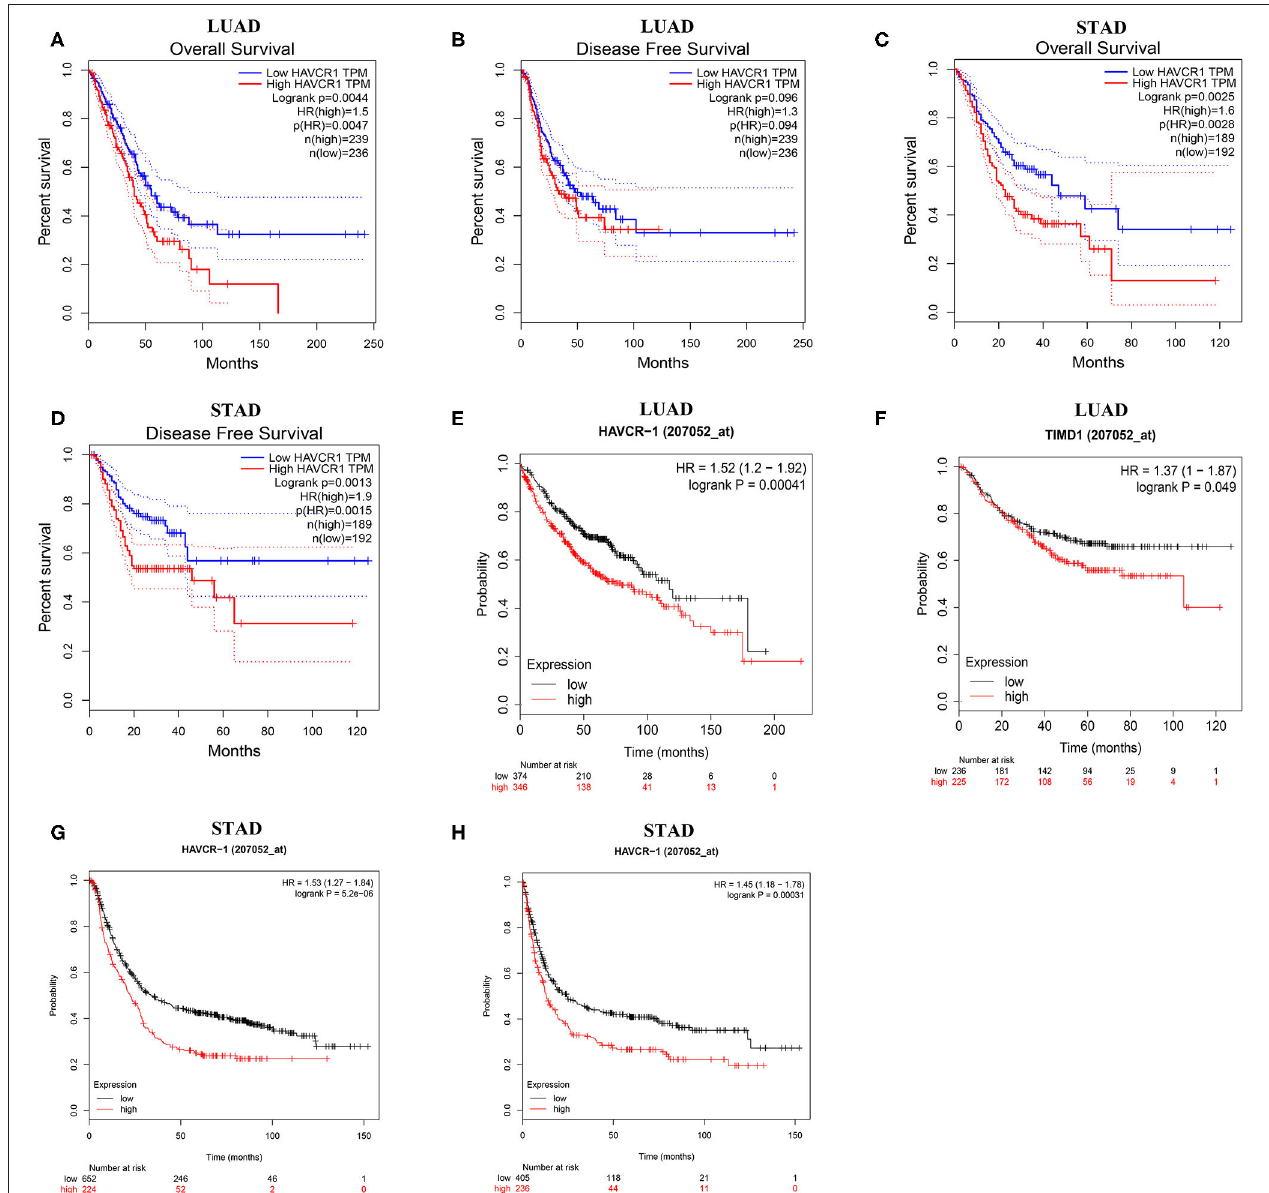
FIGURE 3 | Kaplan-Meier survival curves comparing the high and low expression of TIM-1 in different types of cancer in the TCGA dataset and GEO dataset. (A–D) Survival curves of OS and DFS in gastric cancer and lung adenocarcinoma in TCGA cohorts. (E,F) Survival curves of OS and PFS in six lung adenocarcinoma cohorts (GSE29013, GSE31210, GSE31908, GSE43580, GSE50081, GSE8894). (G,H) Survival curves of OS and PFS in six gastric cancer cohorts (GSE62254, GSE14210, GSE15459, GSE22377, GSE29272, GSE51105).